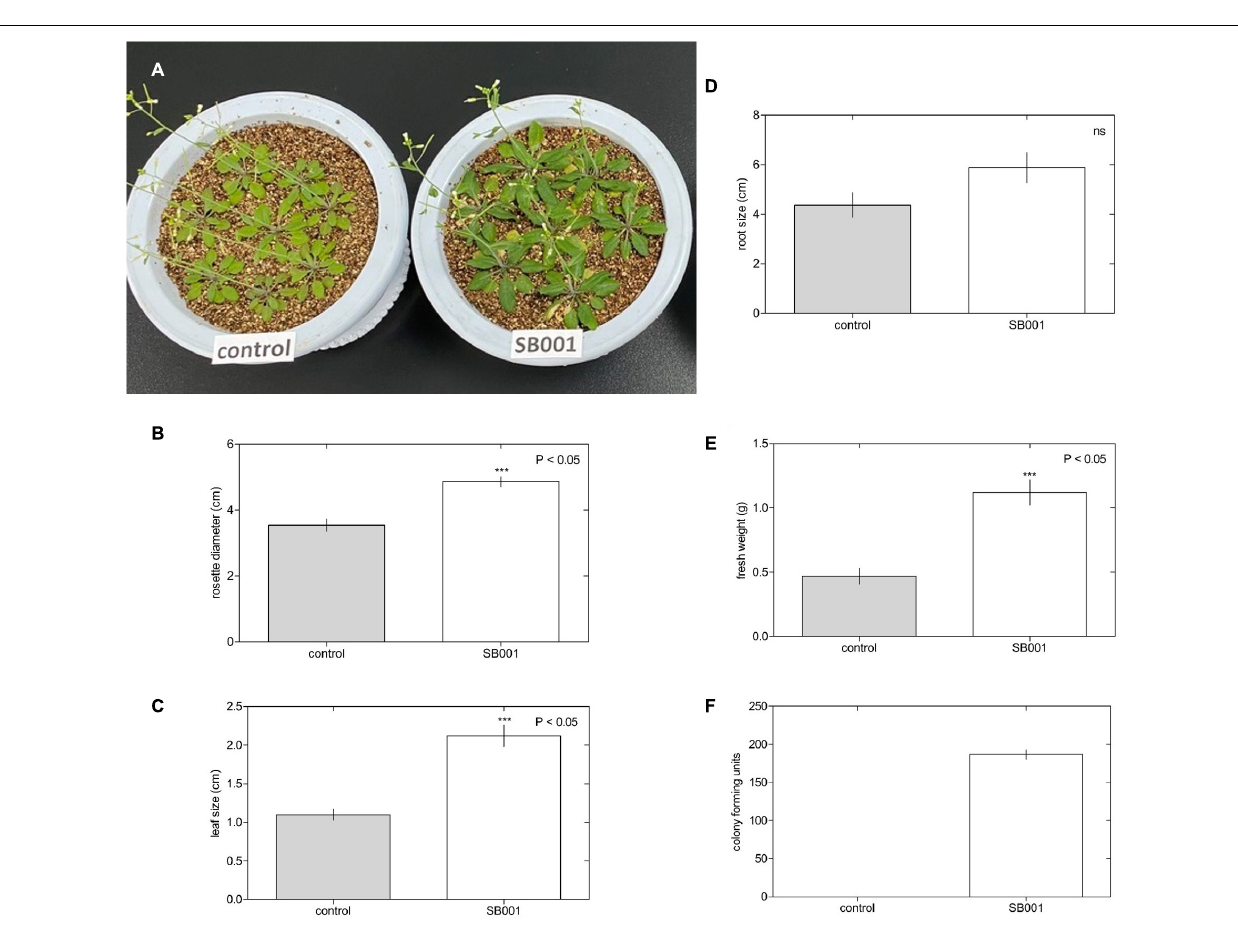
Frontiers in Microbiology |